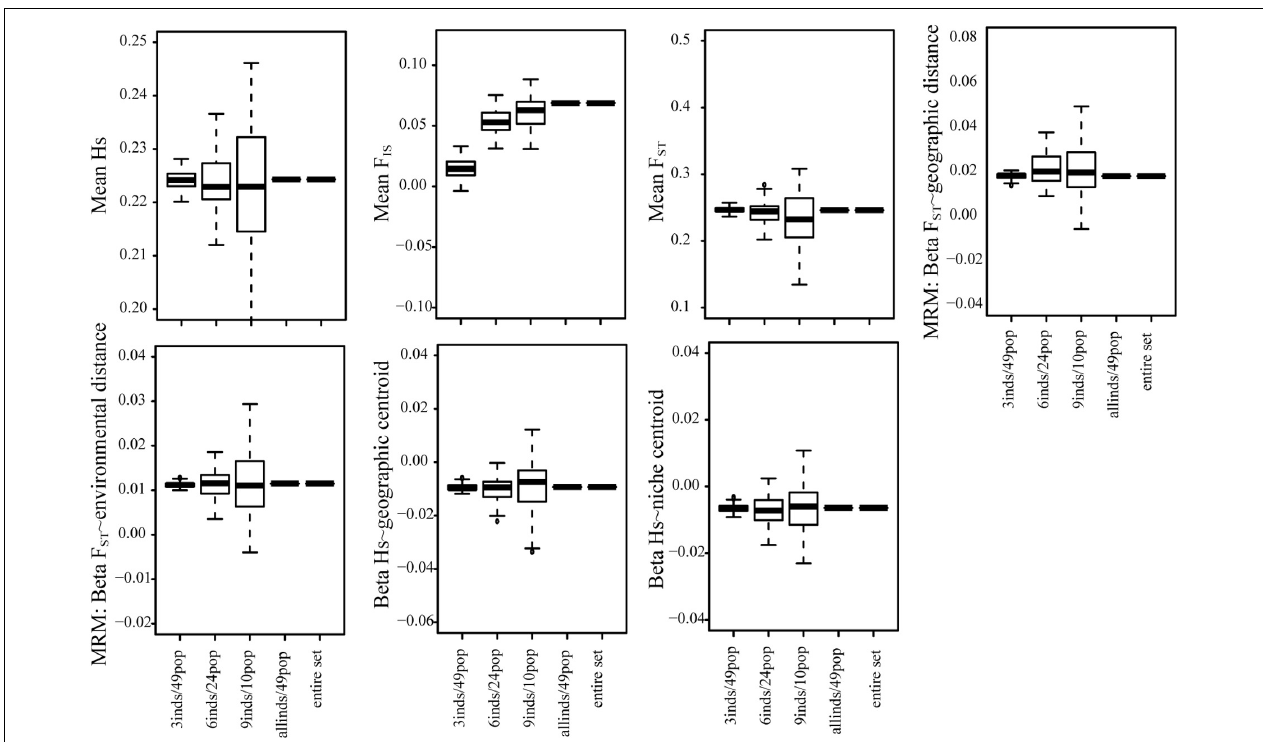
FIGURE 4 | The tradeoff between the number of individuals and the number of populations sampled for all summary statistics using the 50K dataset. We tested the effect of sampling more individuals in fewer populations and fewer individuals in many